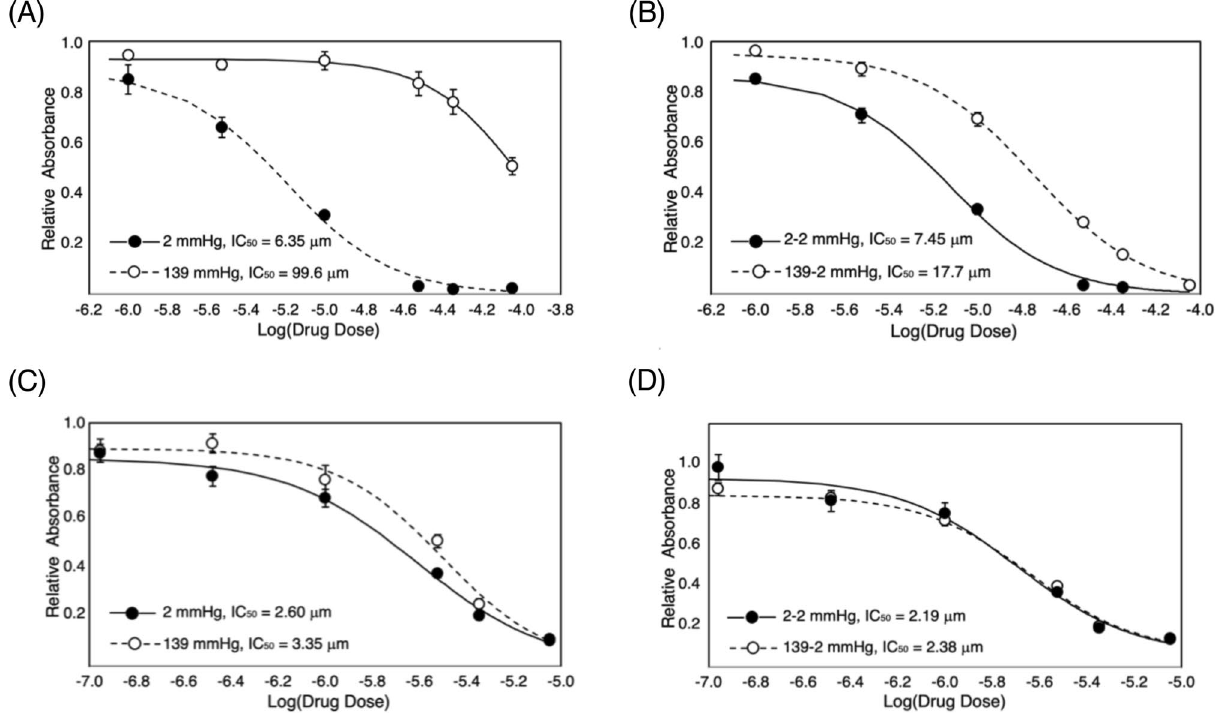
Figure 5. Drug dose response of PANC1 cells to ( A ) tirapazamine under static and ( B ) under cycling hypoxia and ( C ) doxorubicin under static and ( D ) cycling hypoxia